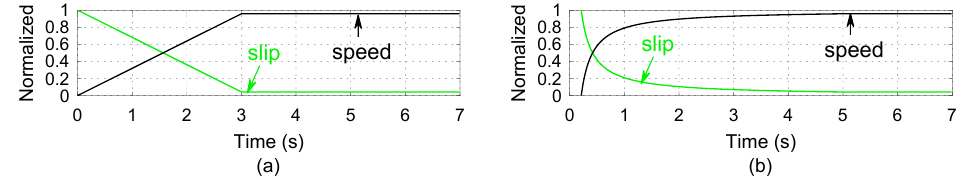
Figure 2. Representation of motor speed and slip during a startup transient, when the motor is started by: ( a ) from the line, and ( b ) by an adjustable speed drive.